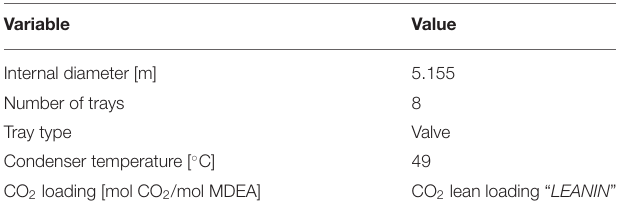
TABLE 3 | Design parameters and specifications of the stripping